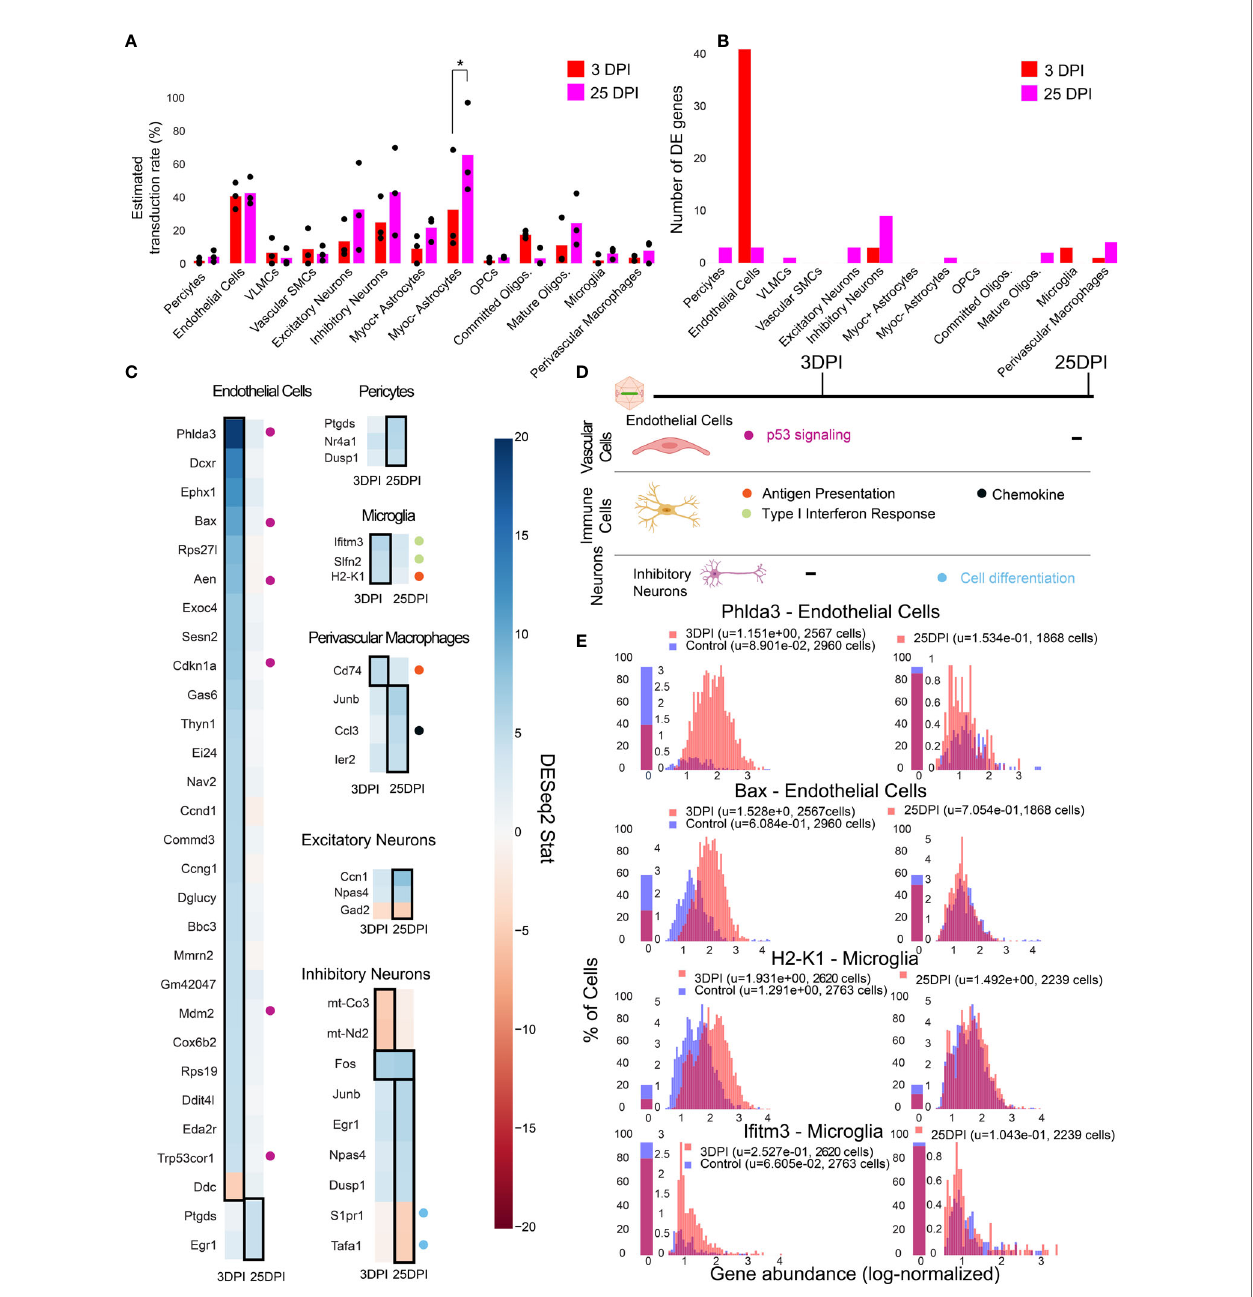
FIGURE 5 | Single-cell gene expression pro fi ling fi nds cell-type-speci fi c responses to AAV transduction in endothelial cells. (A) Estimated transduction rate (%) of mNeonGreen cargo at three and twenty- fi ve days post-injection (DPI). Results from a two-way ANOVA with correction for multiple comparisons using Sidak ’ s method is reported with adjusted P-values (*P ≤ 0.05 is shown; and P > 0.05 is not shown on the plot). (B) Number of differentially expressed genes (adjusted P- value < 0.05, DESeq2) at 3 DPI and 25 DPI across 3 animals. (C) Differentially expressed genes across the two time points in endothelial cells, pericytes, microglia, perivascular macrophages, inhibitory neurons, and excitatory neurons. Color indicates DESeq2 test statistic with red representing downregulation and blue representing upregulation. Genes outlined by a black rectangle are determined to have statistically signi fi cant differential expression compared to controls (adjusted P-value < 0.05, DESeq2, after Benjamini/Hochberg multiple comparison correction across all cell types and conditions). Colored circles adjacent to each gene indicate the corresponding pathway presented in (D) . (D) A summary of corresponding pathways in which the differentially regulated genes in (C) are involved across the time points. (E) Distribution of p53 signaling transcripts in endothelial cells (3 animals are combined) and an example of an MHC-I gene upregulated in microglia at 3